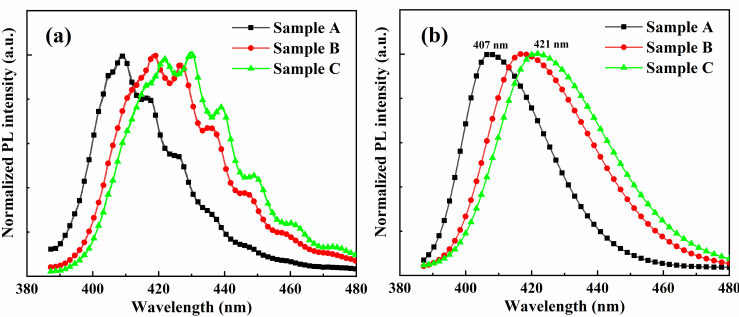
Figure 6. Photoluminescence spectrums of Sample A, Sample B and Sample C at room temperature: ( a ) experimental data; ( b ) fitting